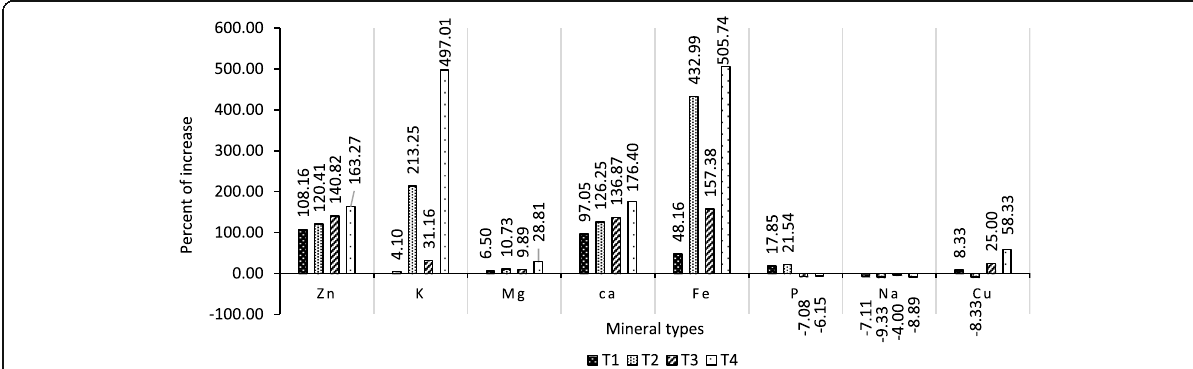
Fig. 2 Percent increase of minerals content in extruded snacks. T1, T2, T3 and T4: extruded corn products fortified with 3% (w/w) of laurel, turmeric, ginger and mixture formula contains 3% of the three herbs ’ mixture mentioned (1:1:1),